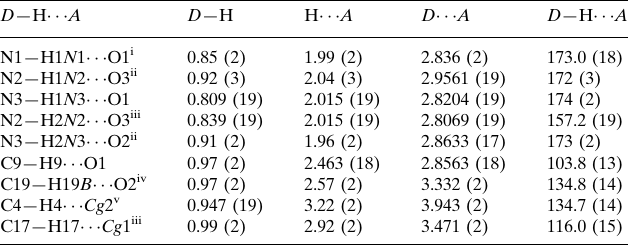
Hydrogen-bond geometry (A˚ , (cid:3)